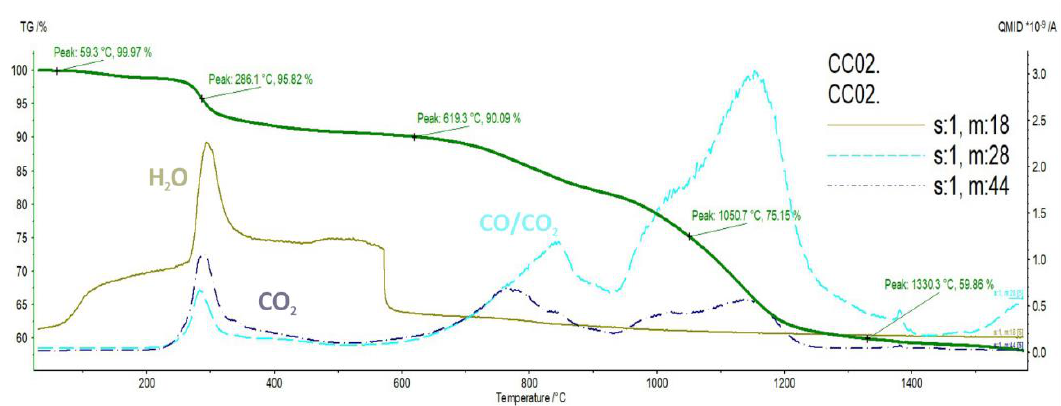
Figure 4. CC02 thermogravimetric analysis combined with mass spectroscopy (TGA-MS) diagram.